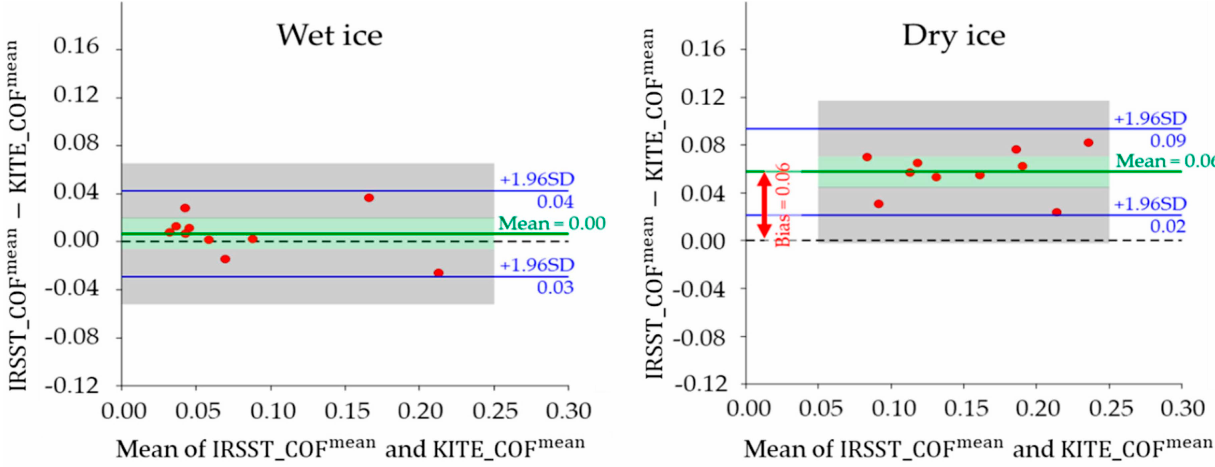
Figure 9. The Bland–Altman plot for COF mean values from KITE and IRSST devices on ( a ) wet and ( b ) dry ice. The green and gray zones represent the confidence intervals around the mean and the LoA, respectively.